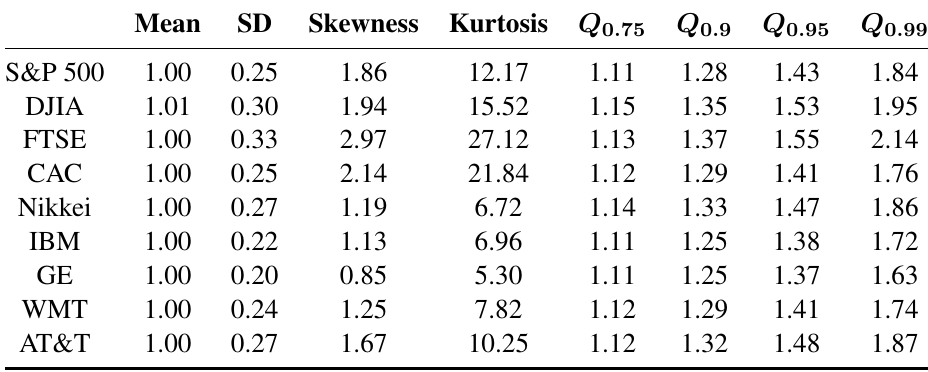
/ (cid:100) RV ratios. WMT, Wal-Mart. t t